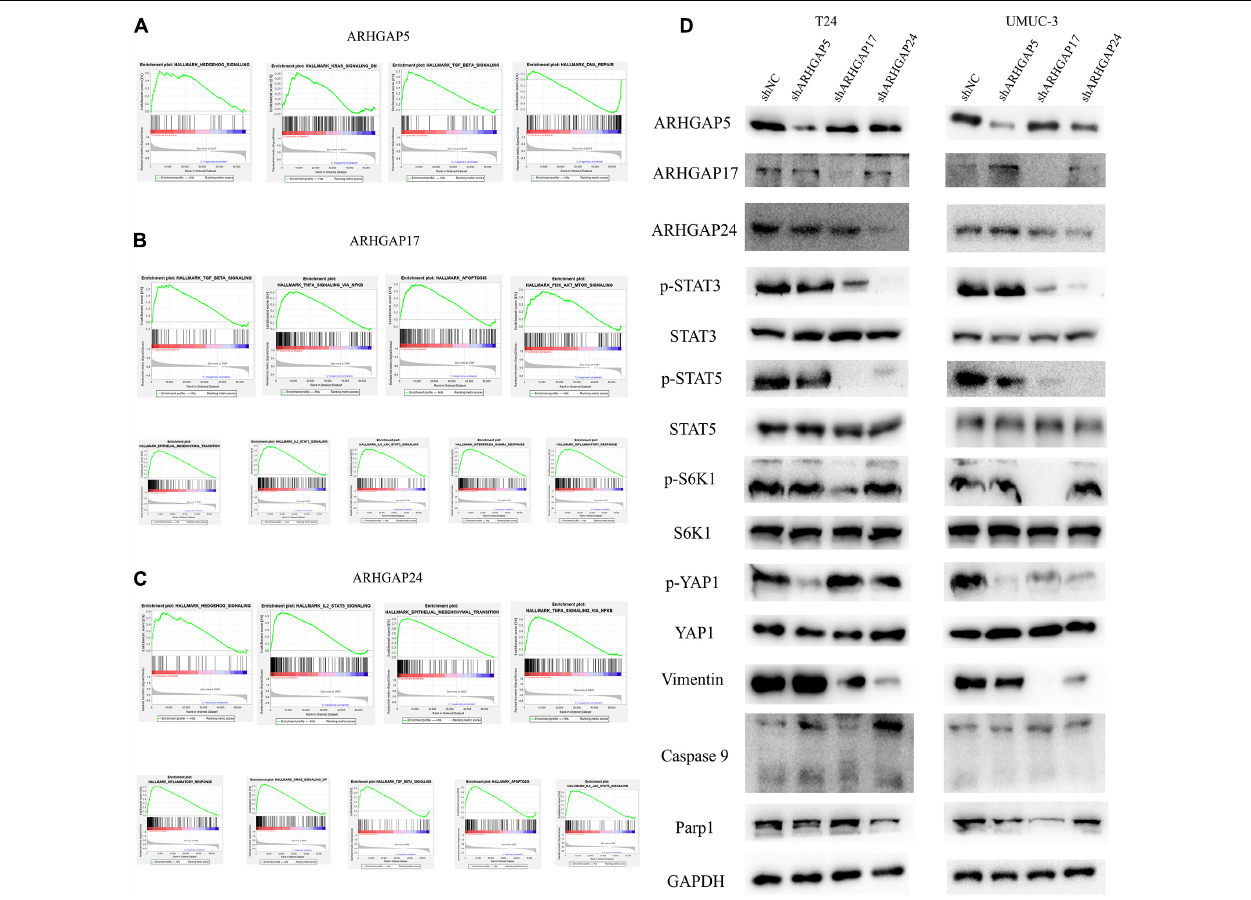
FIGURE 7 | Molecular mechanism of representative ARHGAP family genes in BC biological process. Gene set enrichment analysis (GSEA) plot of (A) ARHGAP5, (B) ARHGAP17, and (C) ARHGAP24, p < 0.05. False discovery rate (FDR) < 0.25. (D) Western bolt analysis of p-STAT3, STAT3, p-STAT5, STAT5, p-S6K1, S6K1, p-YAP1, YAP1, vimentin, caspase 9, and Parp1 in T24, UMUC-3, and ARHGAP5, ARHGAP17, and ARHGAP24 knocking down T24,